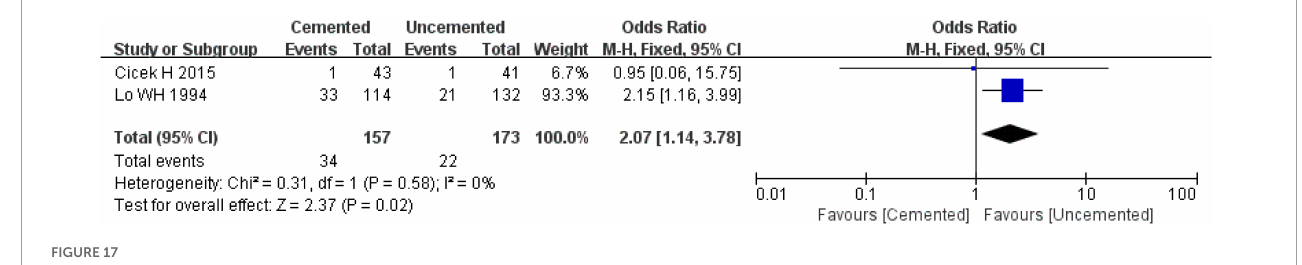
changes in the results, indicating that the heterogeneity had little influence on results and the findings were relatively